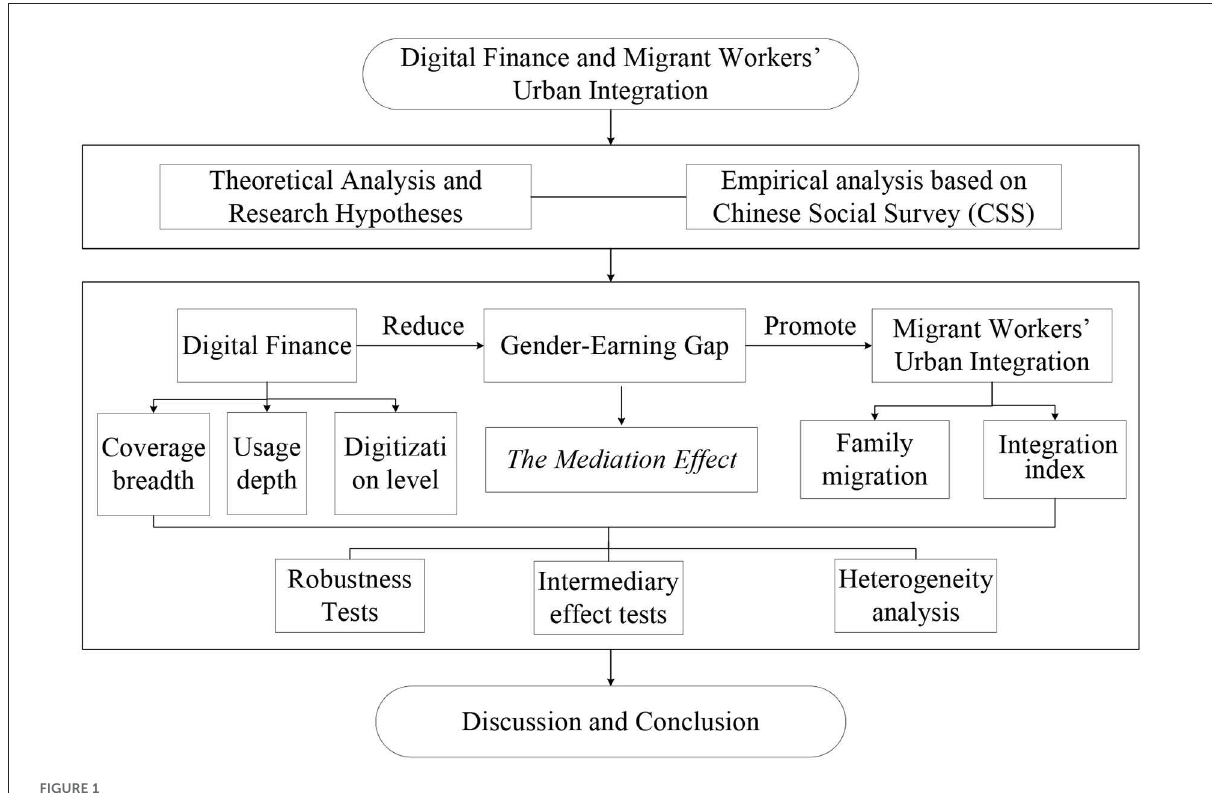
FIGURE1 Technical